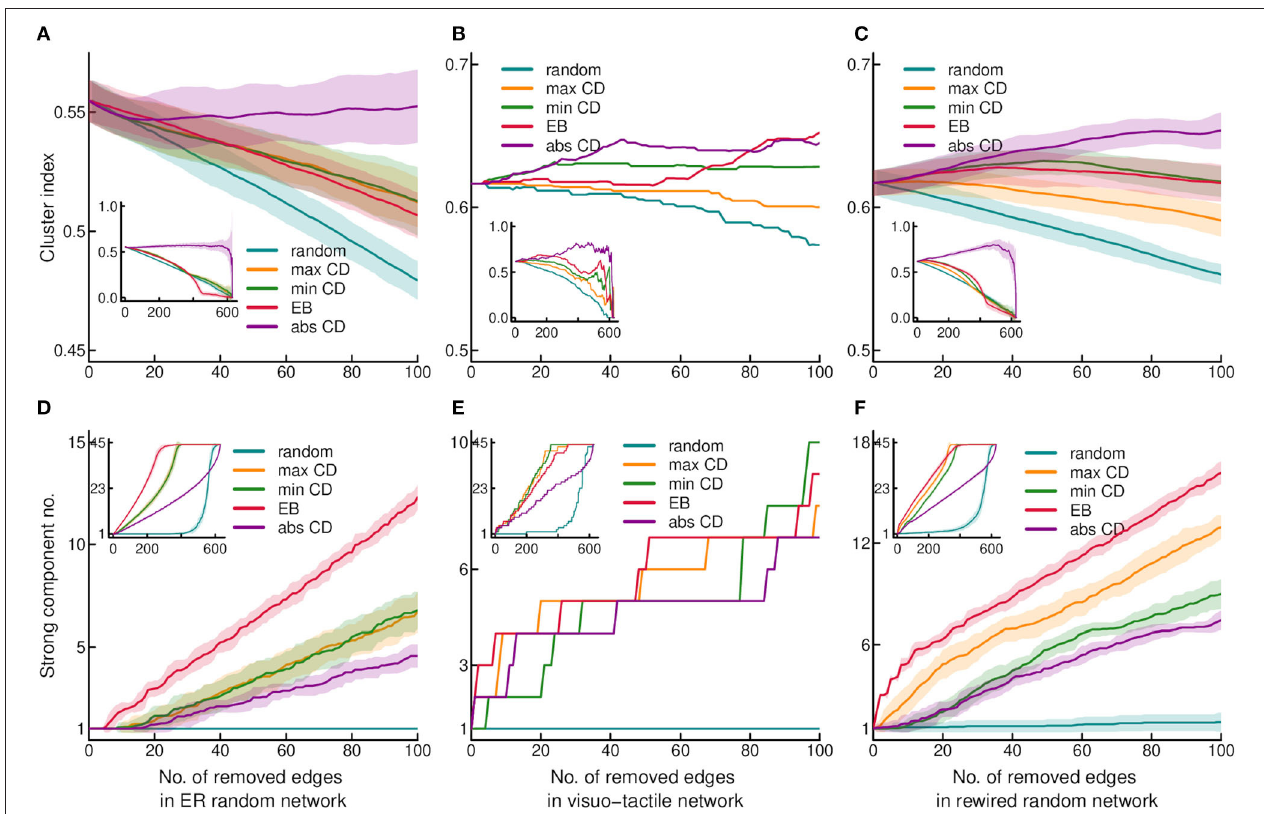
FIGURE 1 | Effect of edge removal on the cluster index and strong connectedness. Cluster index and the number of strongly connected components are shown as the function of stepwise edge removals in the upper (A–C) and lower (D–F) rows, respectively. Middle column shows results obtained in the binary visuo-tactile network (B,E) . Left and right columns show the results obtained in the Erd ˝ os-Rényi (ER) random graphs (A,D) and rewired randomized control networks (C,F) , respectively. The graphs show the result of the first 100 edge removals, while the insets contain the process for the entire graph. Edge properties were recomputed after each step of removal. In randomized networks, the average of 30 graph instances is shown with shading indicating the standard deviation. Targeted edge removal was executed according to maximum CD (maxCD), minimum CD (minCD), absolute CD (absCD), and edge betweenness (EB) values. The results of random edge eliminations are also shown for